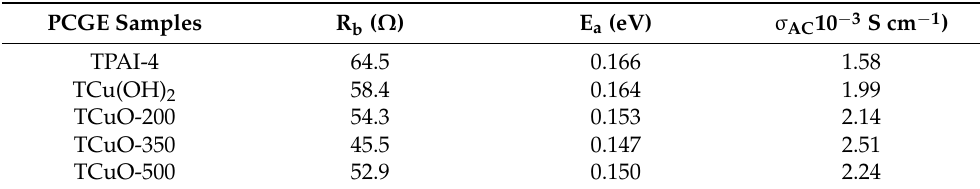
Figure 5. ( a ) Cole–Cole plot of all PCGE samples, ( b ) ionic conductivity of PCGE samples, ( c ) illustration of interaction between different shape of copper oxide nanofiller in the PCGE samples, and ( d ) temperature dependance conductivity plot for all PCGE samples. Table 2. The bulk resistance (R b ), activation energy (E a ), and direct-current conductivity ( σ dc ) values for all PCGE